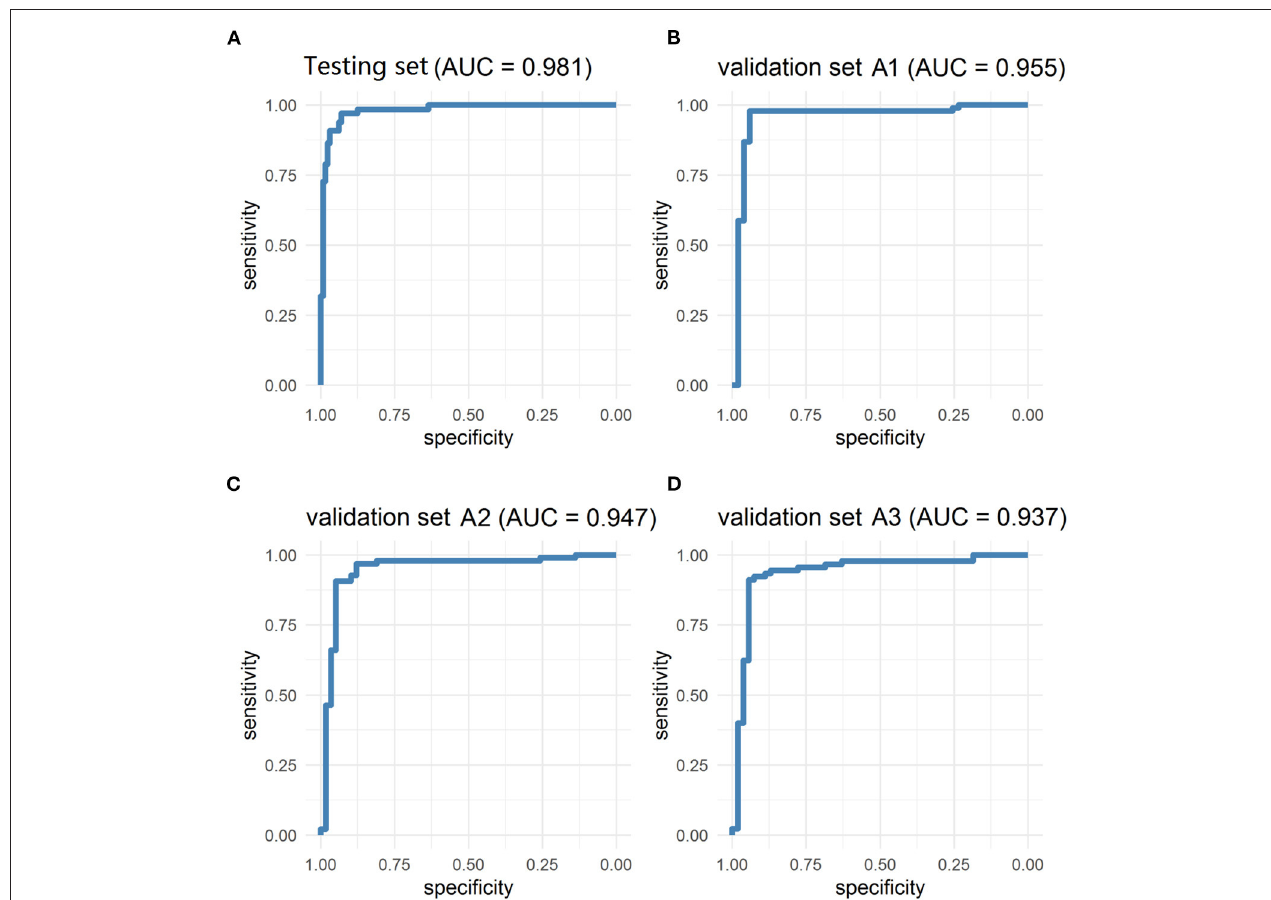
FIGURE 2 | The ROC curves of testing and validation set A1 (Internal dataset), validation set A2 and A3 (external dataset). The model has achieved excellent diagnosis performance in internal and external data sets. (A) The AUC of the testing set was 98.13%. (B) The validation set A1 is a temporal internal dataset, the AUC was 95.46%. (C,D) In the geographical external dataset, the AUC of the validation set A2 and A3 was 94.72 and 93.70%, respectively. AUC, area under the ROC curve; ROC, the receiver operator curve.